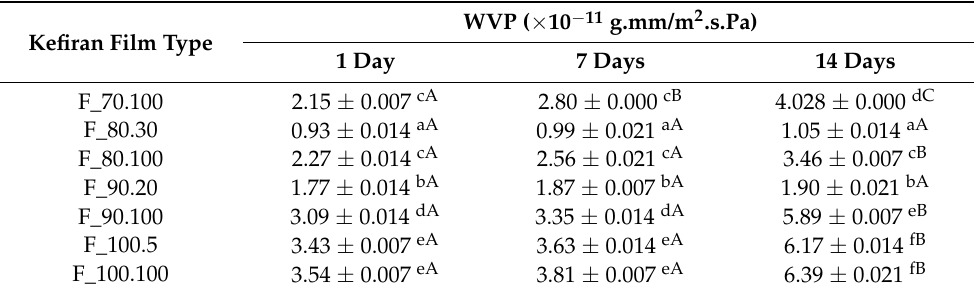
Table 2. Barrier property of kefiran film obtained from the extracted solution under different extraction